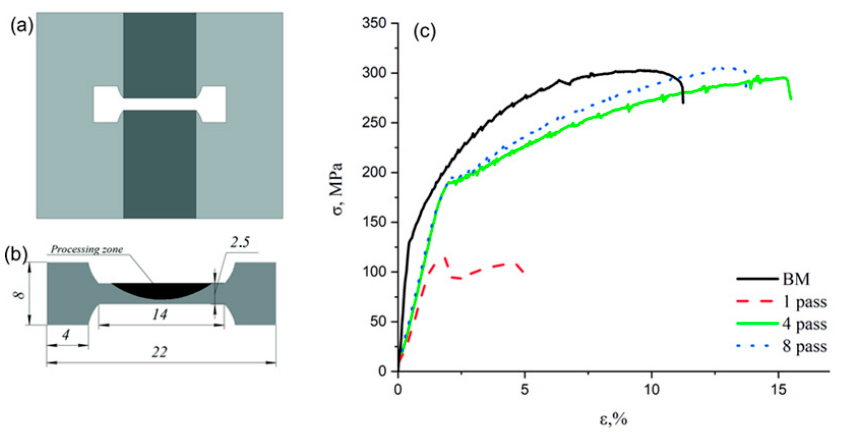
Figure 17. FSP-ed RPPs/AA5056 sample ( a ), tensile test specimen ( b ) and stress–strain curves obtained under quasi-static tension conditions ( c ).